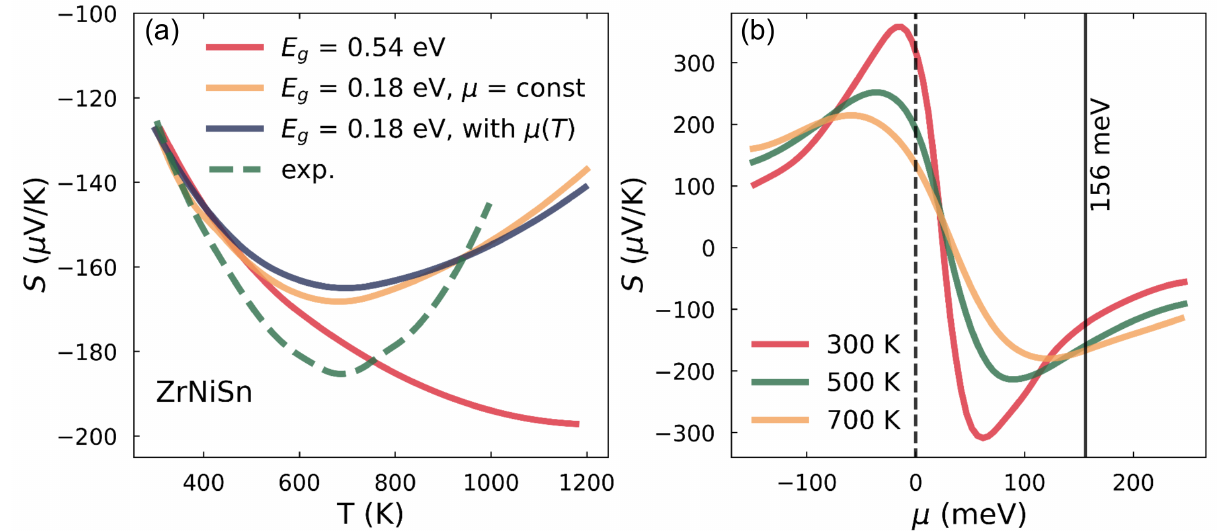
Figure 26. ( a ) The experimental and calculated Seebeck coefficients S with temperature for ZrNiSn. The experimental S is taken from Ref. [180]. ( b ) Seebeck coefficient ( S ) showing the change in the chemical potential for a band gap of 0.18 meV